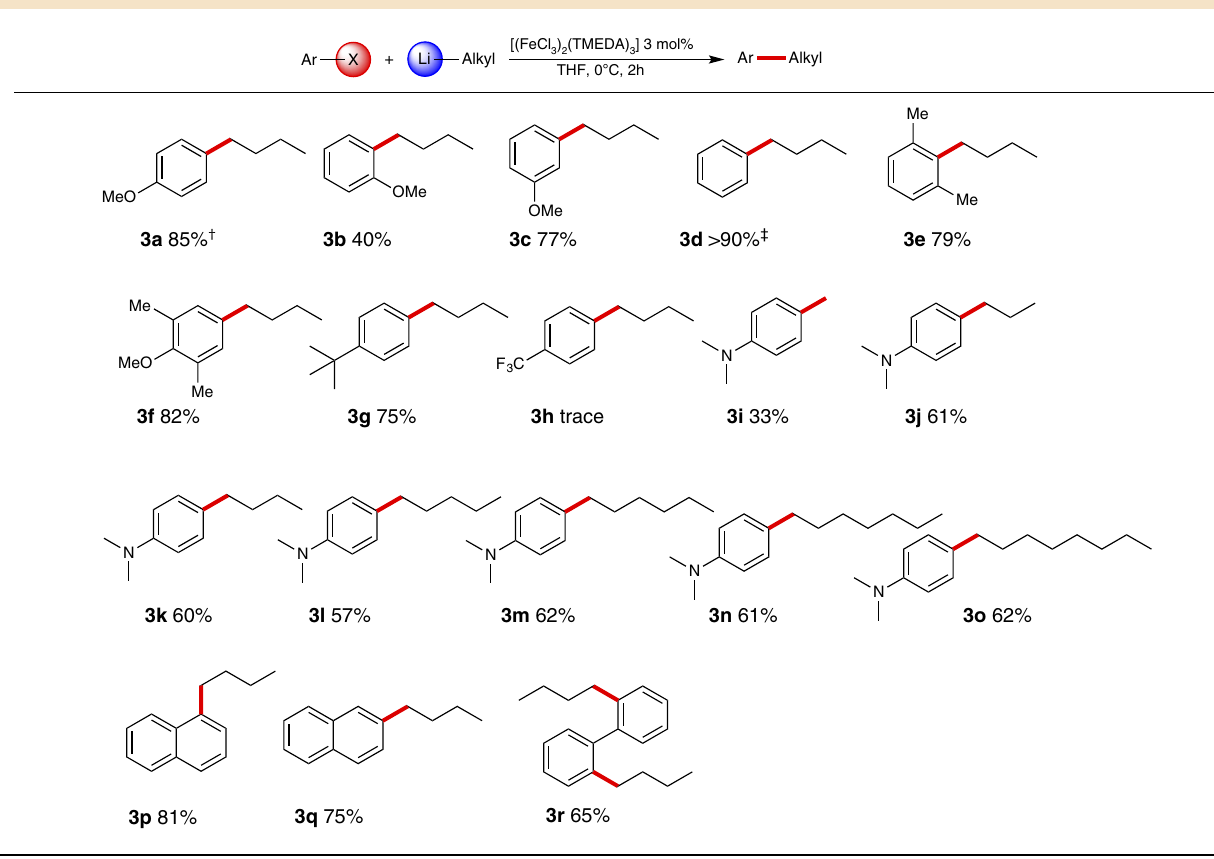
Table 2 | Iron-catalysed cross-coupling of aryl halides with alkyllithium reagents*.